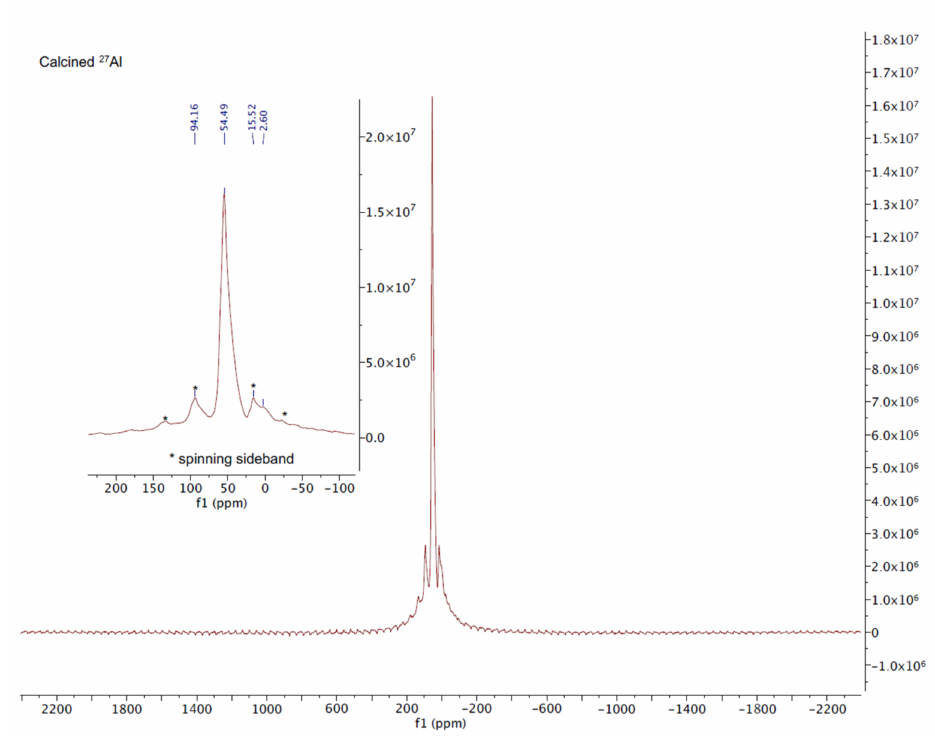
Figure 9. The 27 Al NMR of calcined NV-Na externally referenced to 1M Al(NO 3 ) 3 at 0.0 ppm.